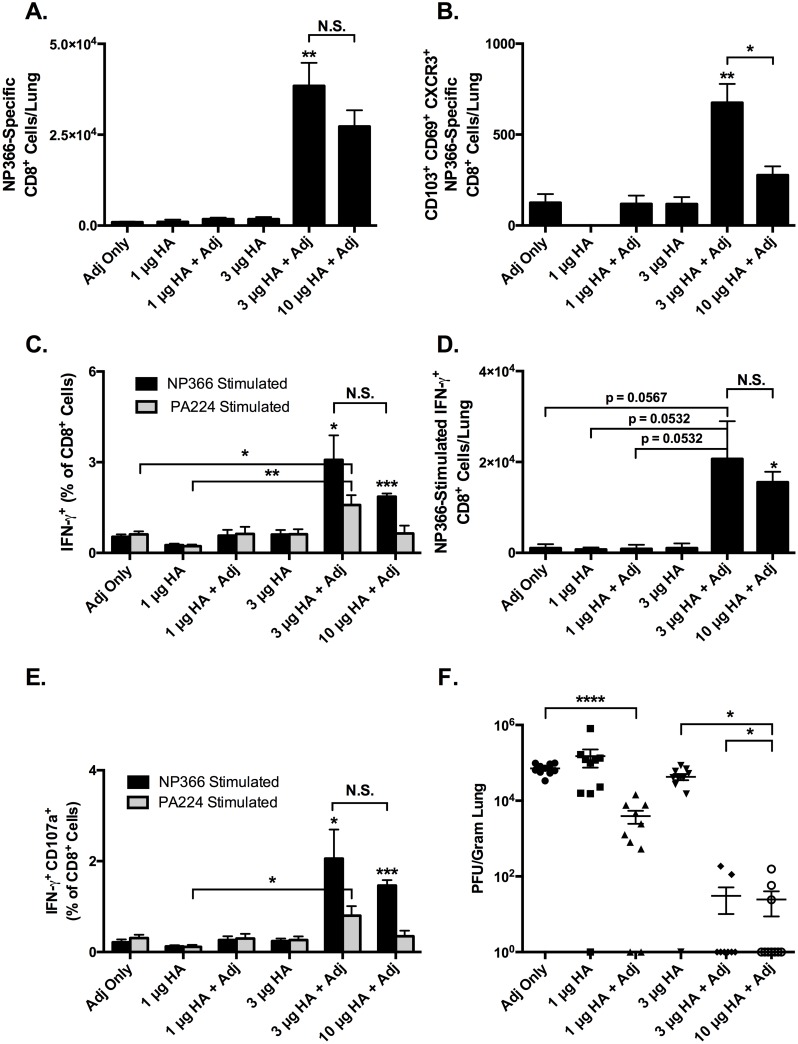
CTL Recall Responses and Protective Heterosubtypic Immunity to Influenza Virus after Prime-boost IN Vaccination.C57BL/6 mice were immunized intranasally with 1, 3, or 10 μg of HA-equivalent of BPL-inactivated influenza strain PR8xTexas/H3N2 in 50 μl PBS with or without 10% ADJ. Note that the vaccine preparation also contains other viral proteins including NP, PA, neuraminidase and matrix proteins. Vaccines were repeated 3 weeks later, and 3 weeks after the second immunization, mice were challenged by IN administration of 200 PFU of influenza A/PR/8/34/H1N1. 6 days after challenge 5 mice/group were sacrificed and lungs were collected for CTL analysis and viral titration. Db/NP366-specific CD8 T cells in lung were quantified by MHC I tetramers or intracellular cytokine staining for IFN-γ. (A) Absolute numbers SIINFEKL-specific IFN-γ+ CTLs in lung. (B) Absolute numbers of CD103+ CD69+ CXCR3+ NP366-tetramer+ CTLs in lungs. (C) Frequencies of IFN-γ-producing CTLs specific for influenza NP366 and PA224 epitopes among all CD8+ cells in the lungs. (D) Total number of IFN-γ-producing CTLs specific for influenza NP366 epitope in the lungs. (E) Frequencies of CTLs double positive for IFN-γ and CD107a (LAMP-1) among all CD8+ cells in the lungs. (F) Lung viral titers expressed as plaque-forming-units (PFU) per gram of lung. * indicates p<0.05, ** indicates p<0.01, **** indicates p<0.0001. In panels A-E only, asterisks over a specific bar indicate significance over other groups, unless otherwise indicated. ** indicates significant difference of 3μg HA+ ADJ group with other groups excluding 10μg HA + ADJ. T-cell data are representative of two independent experiments. Viral titer data is pooled from two separate experiments.